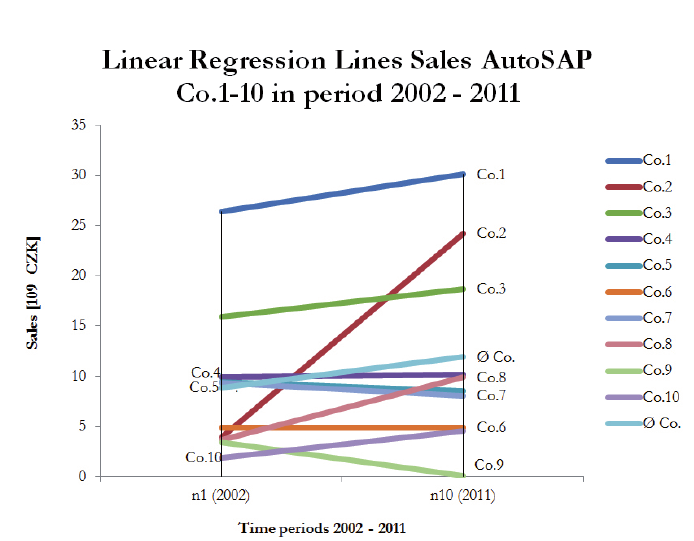
Fig. 6 – Liner Regression Lines Co. RI Sales AutoSAP vs. Time Periods. Source: own